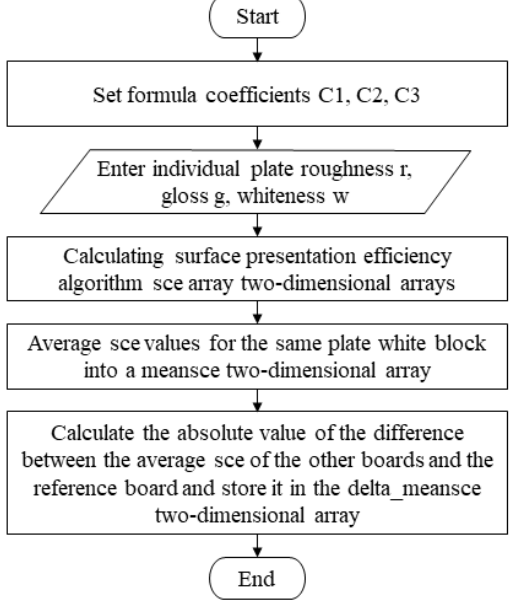
Figure 5. Compilation framework for the proposed SCE algorithm.